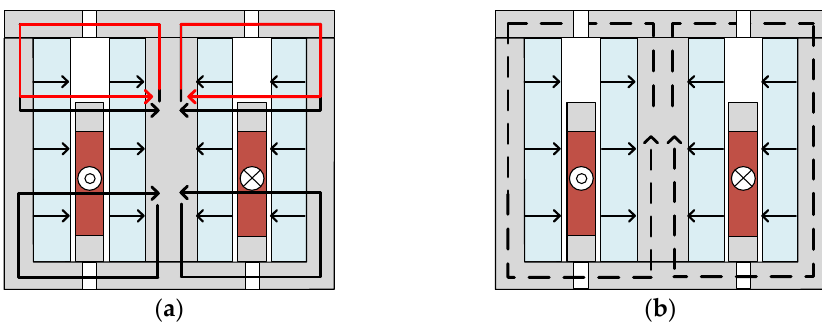
Figure 5. Permanent magnet flux and coil flux. ( a ) Permanent magnet flux, ( b ) coil flux.